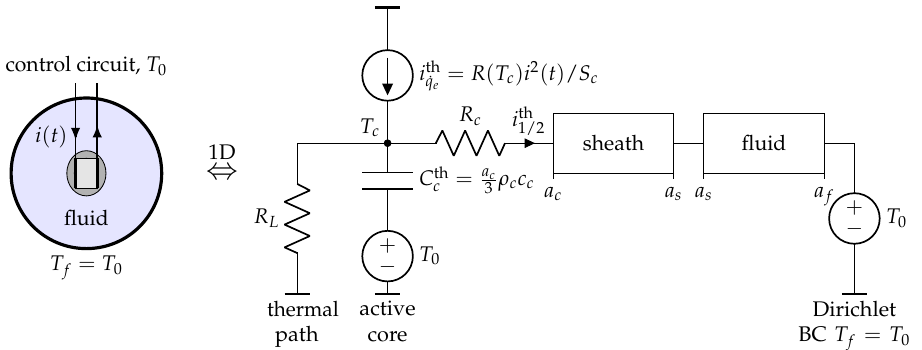
Figure 12. One-dimensional electro-thermal systemic modeling of a bead-type 44004 NTC immersed into a liquid at